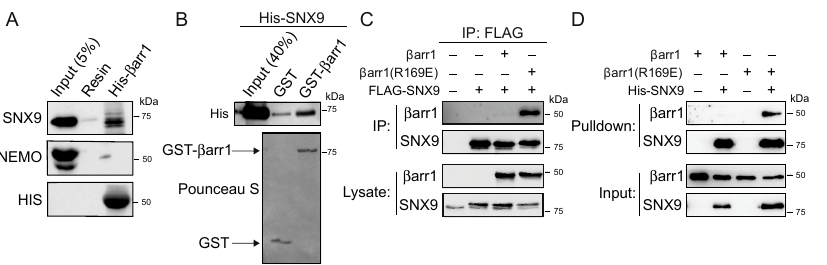
Figure 5. SNX9 interacts directly with β -arrestin1. ( A ) Binding of β arr1 to endogenously expressed SNX9, but not NEMO, in HeLa cells. Immobilized His- β arr1 or empty metal affinity resin was incubated with HeLa cell lysates, and binding reactions were analyzed by immunoblotting. Input represents 5% of the cell lysate used in the binding reaction. NEMO served as a negative control. ( B ) Binding of purified β arr1 to purified SNX9. Equimolar amounts (~1 µ M) of GST- β arr1 or GST immobilized on glutathione-sepharose resin were incubated with purified His-SNX9 (0.3 µ M), and binding reactions were analyzed by immunoblotting for the His tag. Ponceau S-stained blot shows GST and GST- β arr1 from the binding reaction. Input represents 40% of His-SNX9 used in the binding reaction. ( C ) Preactivated β arr1(R169E) preferentially binds to SNX9. Binding of preactivated β arr1 (R169E) to SNX9 in HEK293 cells transiently transfected with FLAG-SNX9 and wild-type β arr1 or preactivated β arr1-R169E. FLAG immunoprecipitates (IP) and lysates were analyzed by immunoblotting by using antibodies against β arr1 and SNX9. The doublet bands shown in the SNX9 immunoblot represent the FLAG-tagged SNX9 (upper band) and endogenous SNX9 (lower band). ( D ) Immobilized His-SNX9 (0.45 µ M) was incubated with wild-type β arr1 or preactivated β arr1-R169E (0.15 µ M), and pulldown and input samples were analyzed by immunoblotting by using antibodies against β arr1 and SNX9. Data ( A – D ) are representative of three independent